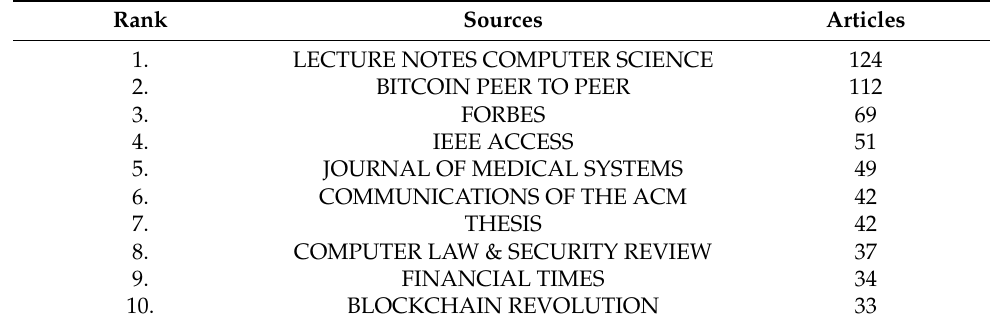
Table 4. Top 10 most local cited sources (from reference lists) during 2015–2019.